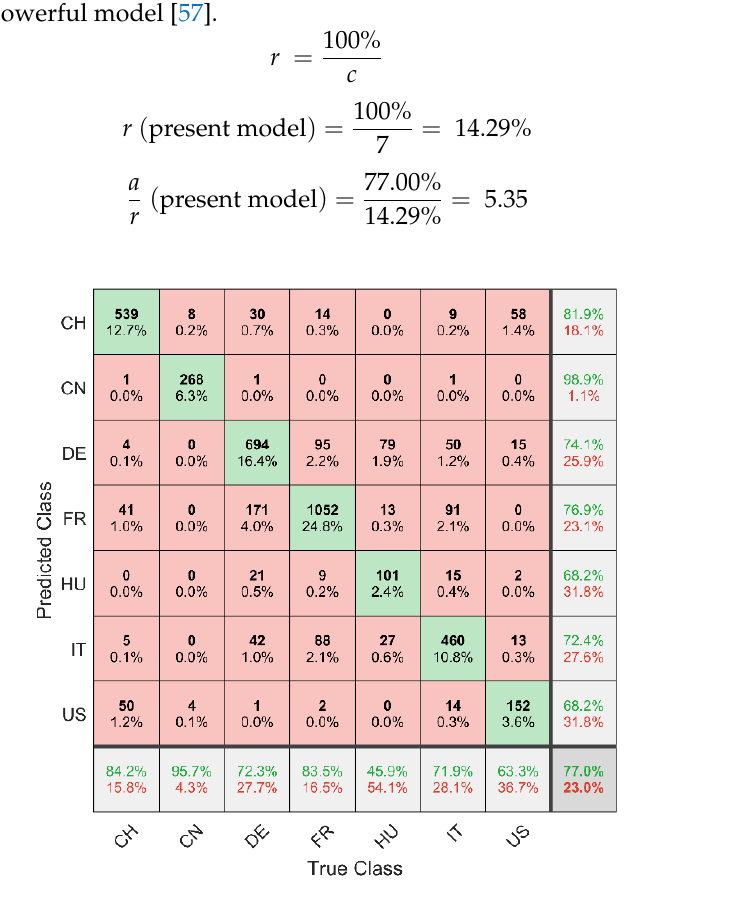
Figure 5. Confusion matrix based on all 212 walnut samples and using the optimized data pre-processing combination (see Table 5, strategy H7). The LDA leads to an overall classification accuracy of 77.00% ± 1.60% (see lower right corner). The values (given in counts) were summed over the 20 repetitions of the nested cv.